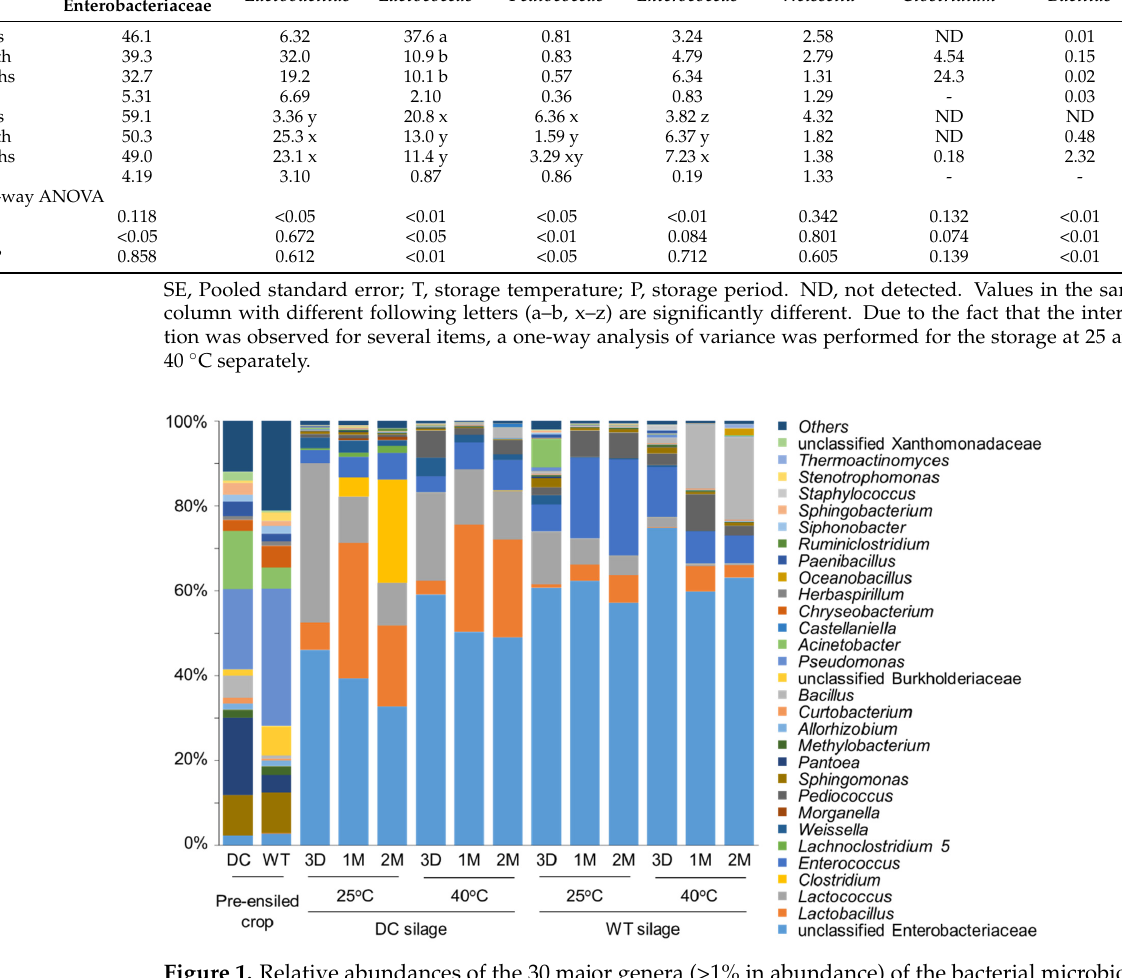
Figure 1. Relative abundances of the 30 major genera (>1% in abundance) of the bacterial microbiota of pre-ensiled crops and silages prepared from direct-cut and wilted guinea grass. DC and WT indicate direct-cut and wilted crops and silages. 3D, 1M, and 2M indicate storage for 3 days, 1 month, and 2 months at 25 and 40 °C, respectively. Table 4. Relative abundances (%) of the eight most abundant bacterial genera in wilted guinea grass silage stored at 25 and 40 ◦ C for 3 days, 1 month, and 2